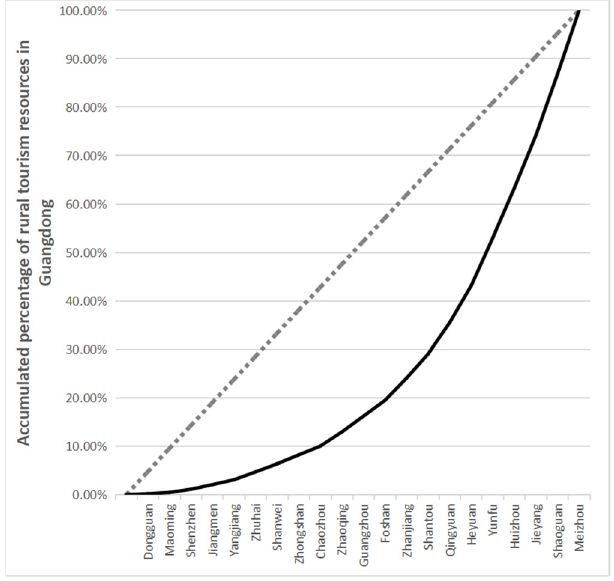
Figure 1. The Gini index of the distribution of rural tourism resources in Guangdong Province. According to the grid-dimensional analysis formula, the probability P ij of Guang- dong’s rural tourism resources and the value of information quantity I( r ) under different grid quantities can be obtained, as shown in Table 2.